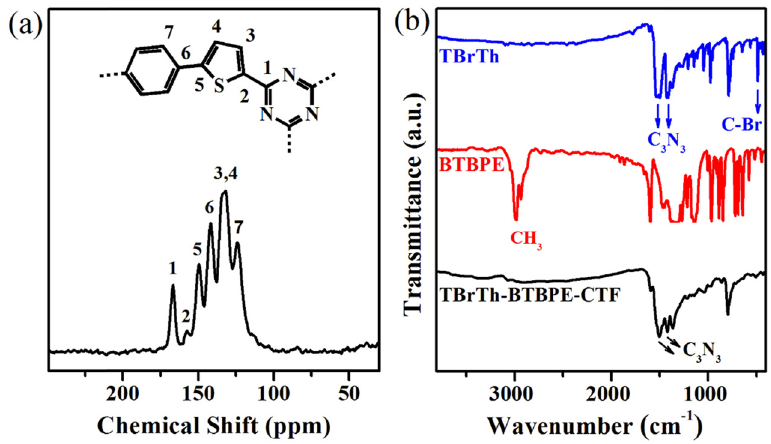
Figure 1: ( a ) Solid - state CP/MAS 13 C NMR spectrum of TBrTh – BTBPE – CTF. ( b ) FTIR spectra of TBrTh – BTBPE – CTF along with the monomers ( TBrTh and BTBPE )